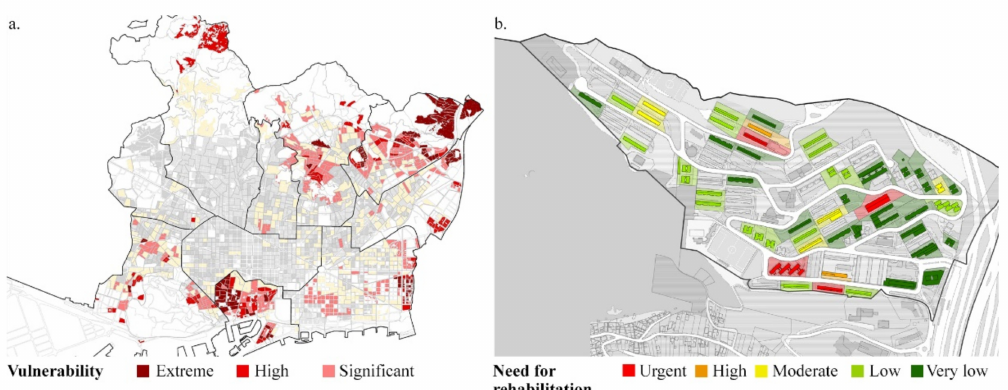
Figure 9. ( a ) Map of vulnerability in Barcelona as a whole. ( b ) Pre-diagnostic map of the Ciutat Meridiana neighborhood. Source: Adapted from